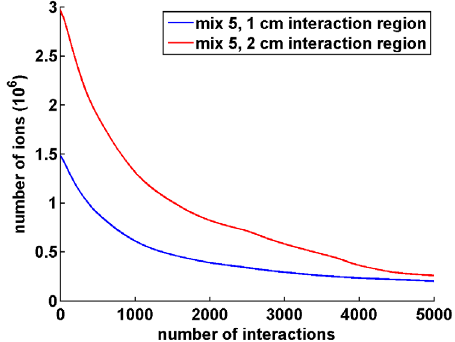
FIG. 6. Clearing times of ion clouds with H þ 2 ions cleared by the field of electrodes with a voltage of − 2700 V. Please note that in the cases of 31 M and 1 M ions the vertical axis is scaled up for the sake of better visibility.